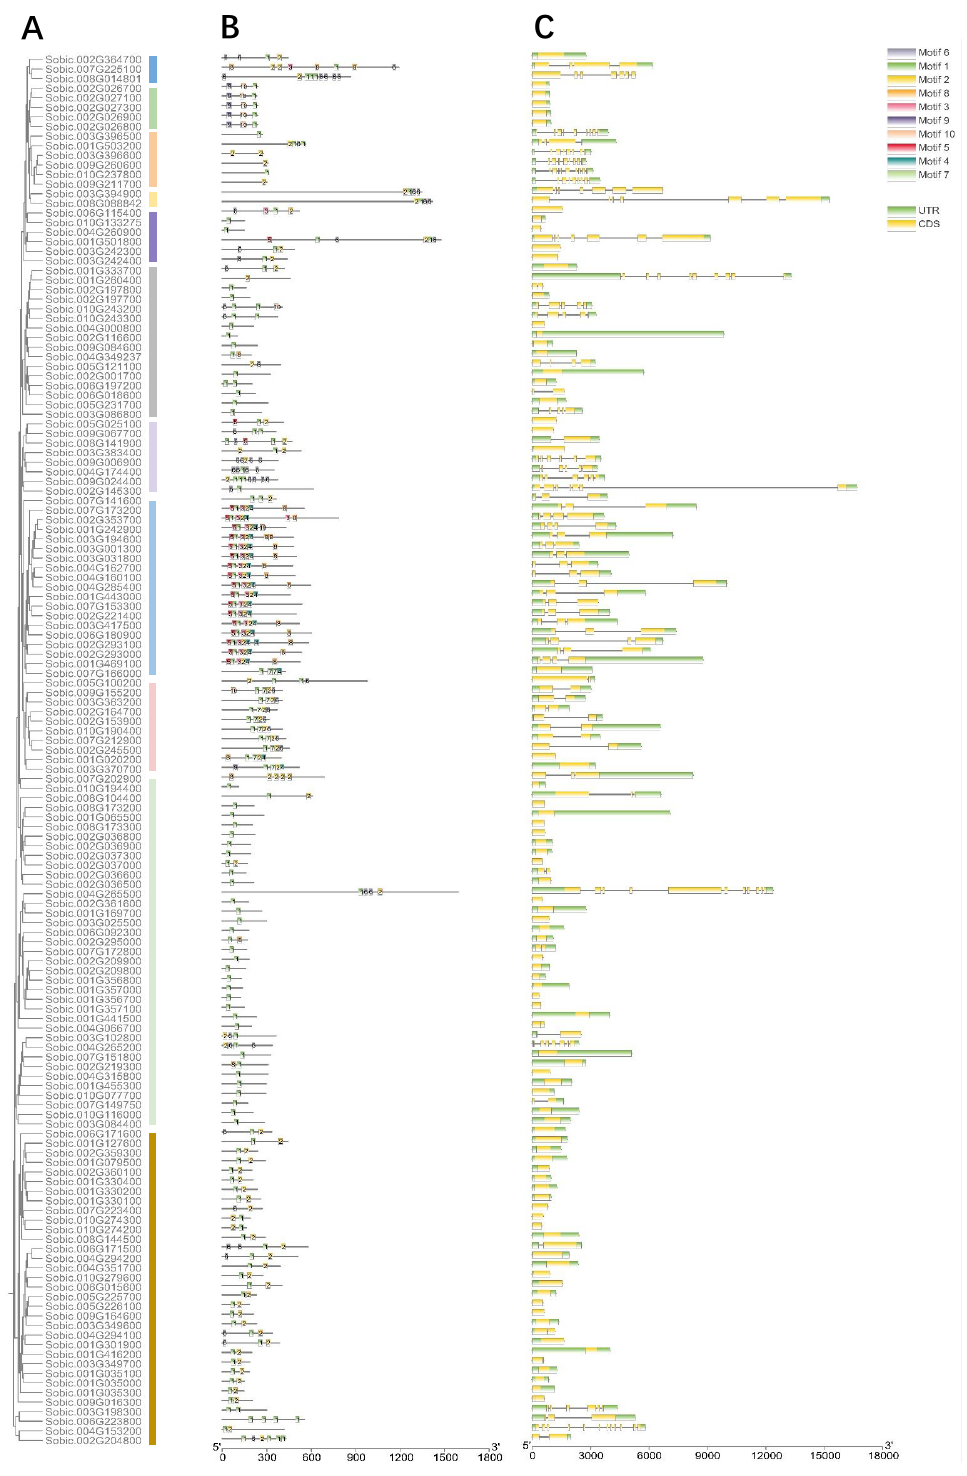
Figure 2. Motif distributions and gene-structure analysis of SbC2H2-ZFP genes. ( A ) The phylogenetic tree was built by the ML method with a bootstrap value of 1000. ( B ) The conserved motifs in SbC2H2-ZFP proteins (1–10) are in different colors. The black lines represent relative protein lengths. ( C ) Exons, introns, and untranslated region (UTR) are represented by yellow rectangles, gray lines, and green rectangles, respectively. The length of SbC2H2-ZFPs is shown